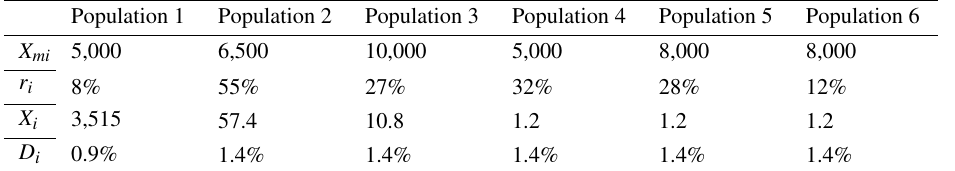
Table 3 Simulation parameters in north